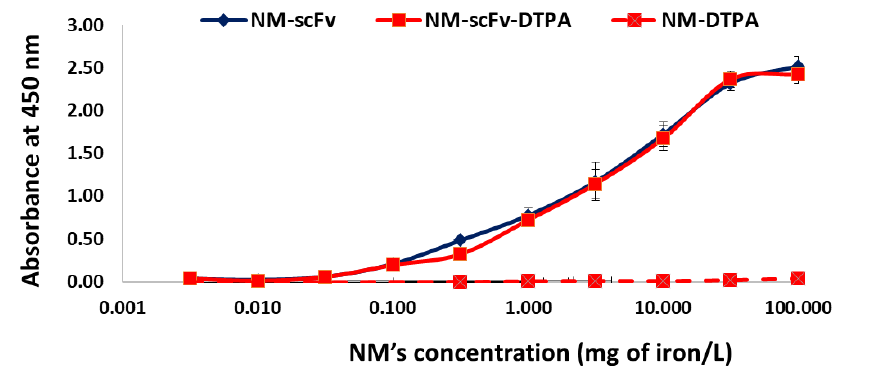
Figure 3. Functionality interpreted by the absorbance at 450 nm of PpL’s substrate obtained from the ELISA experiment of NM-scFv, optimized NM-scFv-DTPA and corresponding NM-DTPA regarding EGFR.